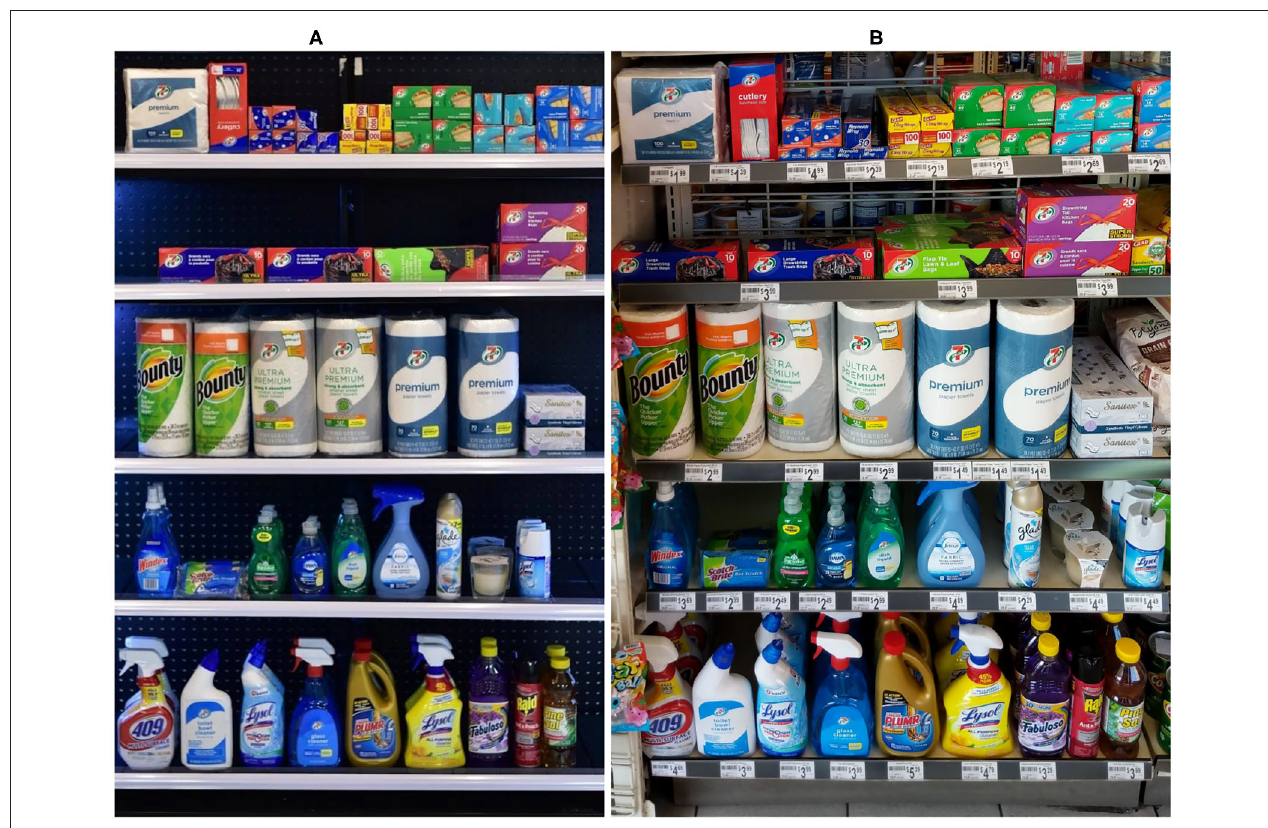
FIGURE 8 | In order to follow a realistic item layout and understand potential failure cases in real deployments, we replicated (A) the layout of a 7-Eleven store (B)